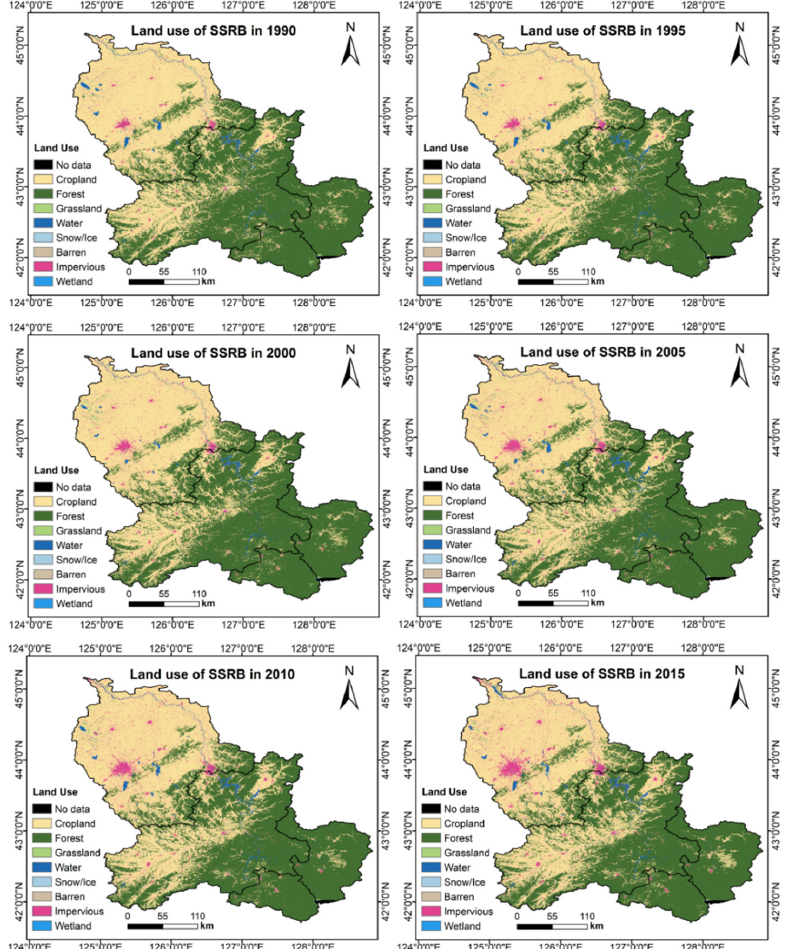
Figure 6. Land-use area in SSR basin during the study period. Table 2. Land-use area in sub-basins during the study period.